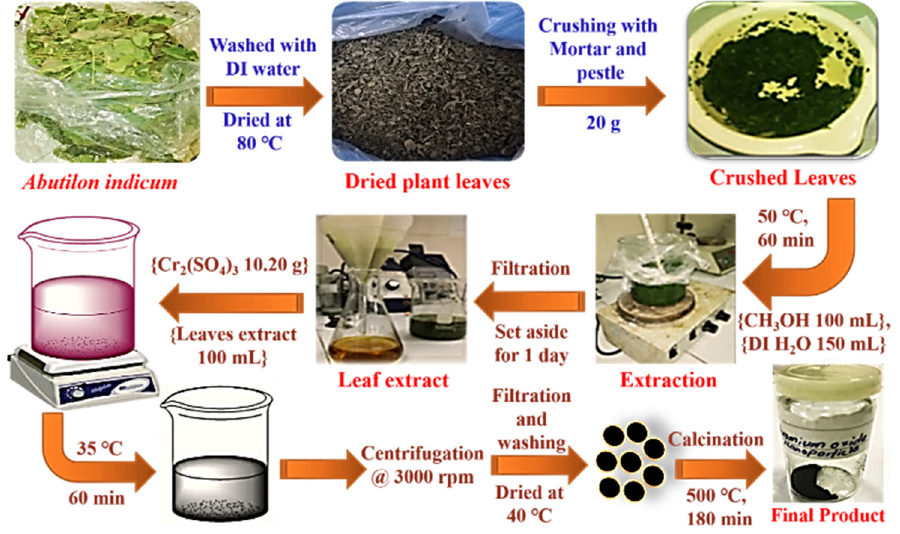
Figure 10. The leaf extraction preparation and green synthesis of Cr 2 O 3 nanoparticles using Abutilon indicum (L.) Sweet leaf extracts.